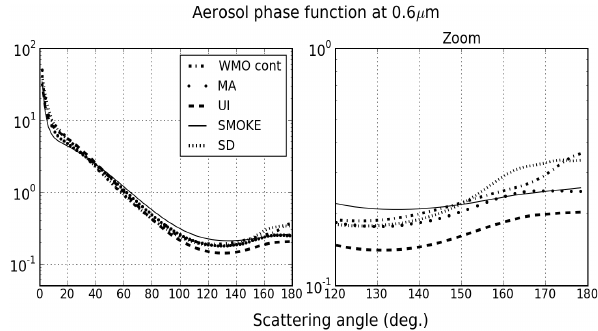
Fig. 3. Aerosol phase function for each 5 models at 0.6 µ m between 0 ◦ and 180 ◦ (left panel). A zoom for the backscattering part (from 120 ◦ to 180 ◦ ) is also plotted (right).